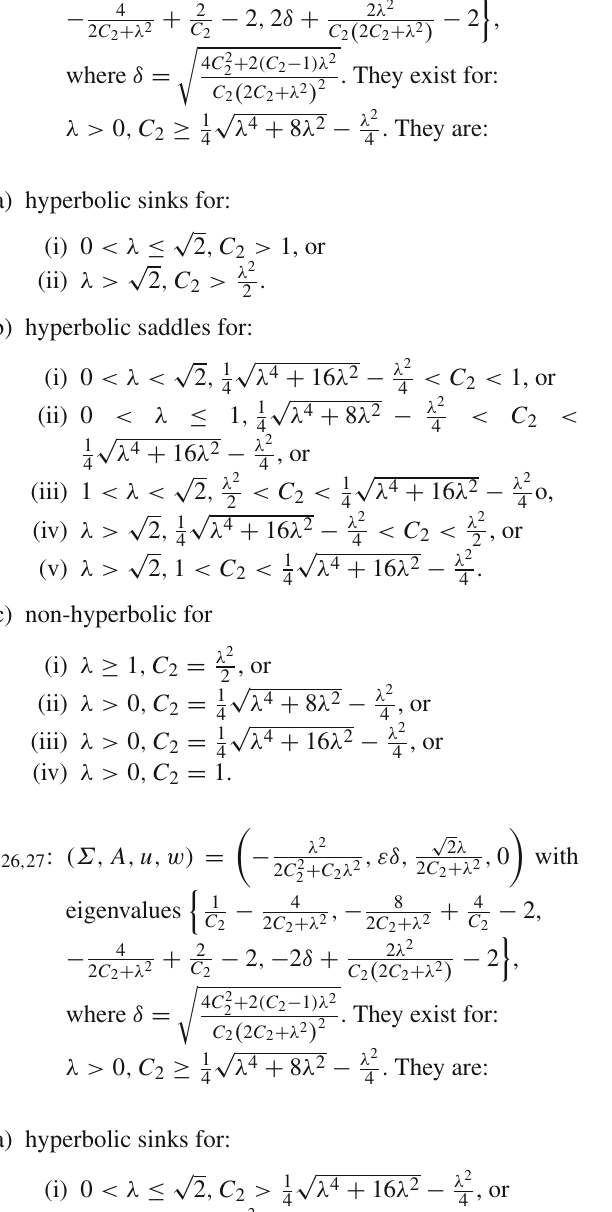
Figure 13 graphically represents the real part of the eigenvaluesoftheequilibriumpoint Q 29 : (Σ, A , u , w) =